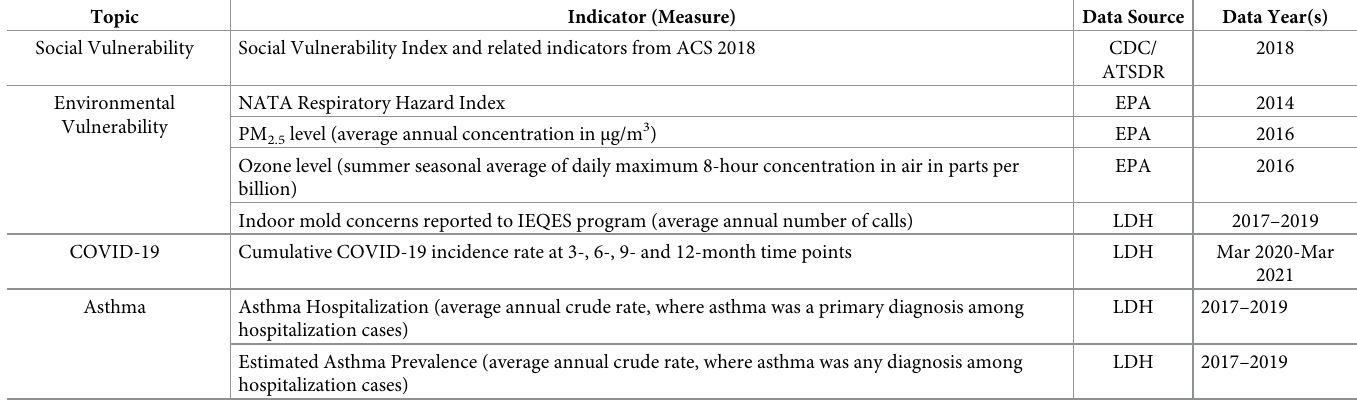
Table 1. Summary of datasets assessed in this study. All datasets were mapped at the census tract level. Topic